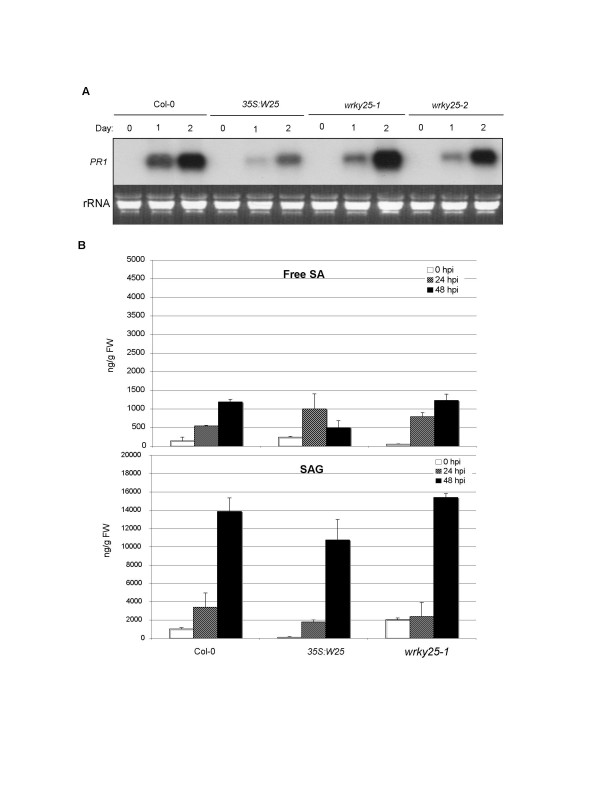
Pathogen-induced PR1 expression and SA accumulation. A. RNA blot analysis of PR1 expression in wild type (Col-0), F3 progeny of transgenic 35S:WRKY25 plants (line 12) and wrky25 mutants following inoculation with PsmES4326 (OD600 = 0.0001). Total RNA was isolated from inoculated leaves harvested at indicated times after inoculation and probed with a PR1 probe. Ethidium bromide-stained rRNA was used as a loading control. The experiment was repeated two additional times with similar results. B. Determination of free and SA glucoside (SAG) levels in wild type (Col-0), transgenic 35S:WRKY25 plants (line 12) and the wrky25 mutants after inoculation with PsmES4326 (OD600 = 0.0001). Inoculated leaves were harvested at indicated times for SA and SA glucoside (SAG) determination. The means and standard errors were calculated from 2–3 replicate samples. FW, fresh weight.